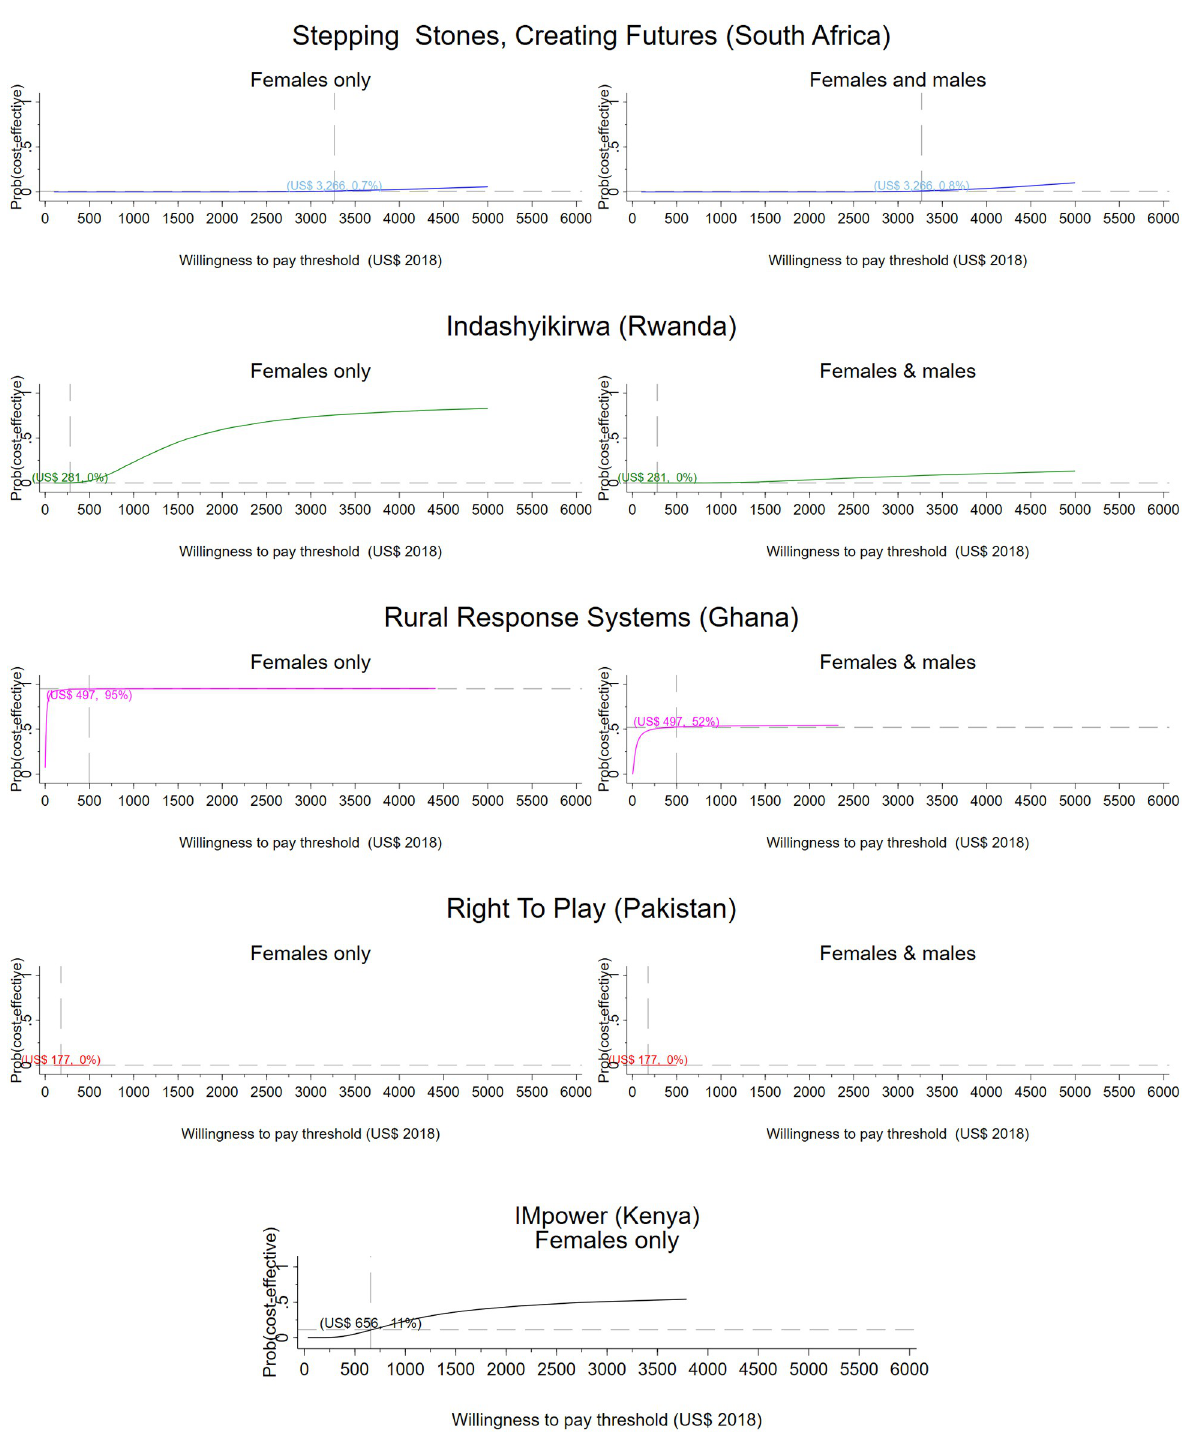
Fig 3. Scale-up scenario 1, provider perspective. CEACs illustrating the probability that the intervention is effective for a range of thresholds. Dashed vertical line: country-specific opportunity cost threshold; dashed horizontal line: probability that the intervention is cost-effective at the country-specific threshold, given the cost per DALY averted by the intervention. CEAC, cost-effectiveness acceptability curve; DALY, disability- adjusted life year.